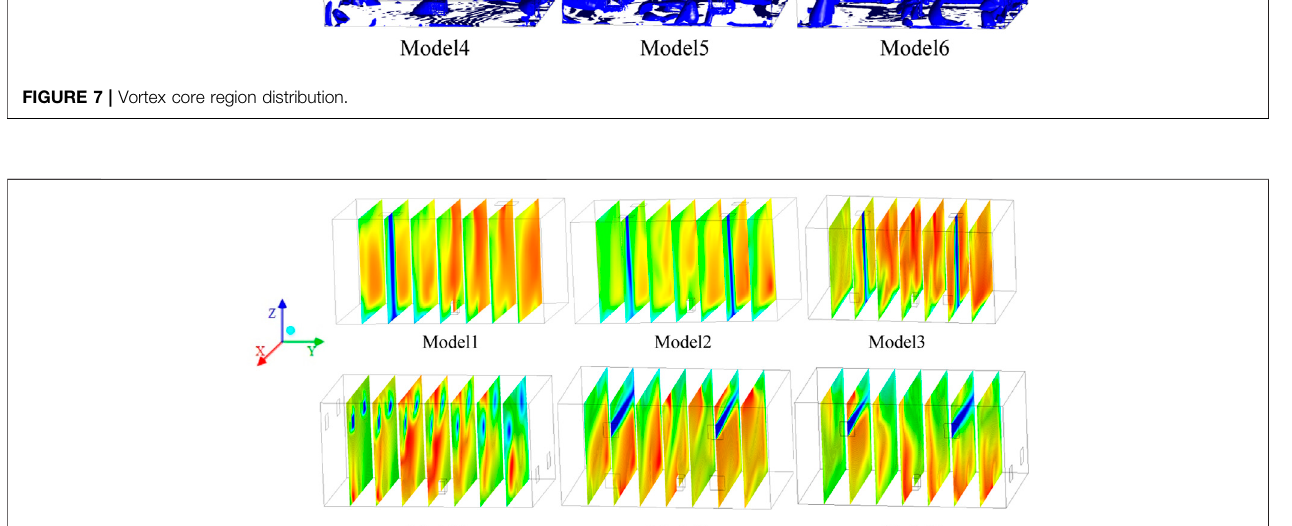
FIGURE 8 | t = 830 s, tritium concentration distribution in the space, kg · m − 3 .